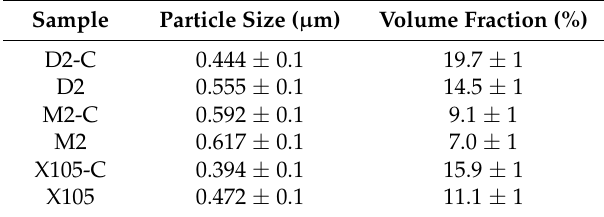
Table 3. Particle size and volume fraction (%) estimated using image analysis software.